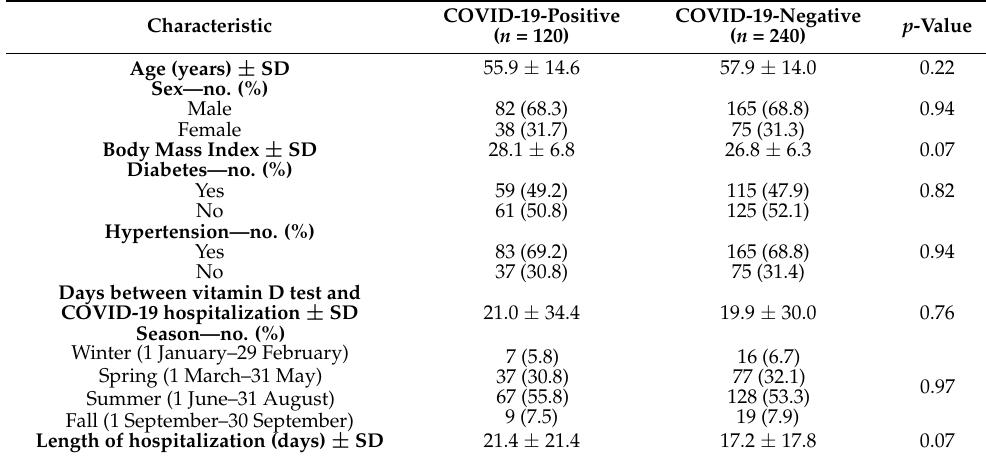
Table 5. Characteristics of hospitalized COVID-19 study population and